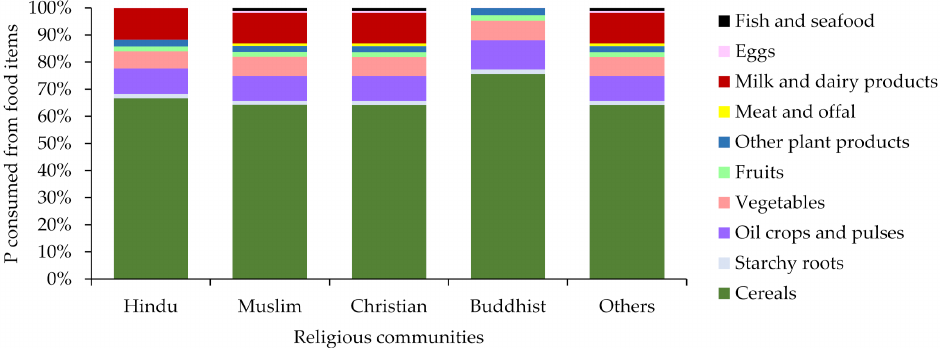
Figure 3. Phosphorus consumed from food by religion in India in